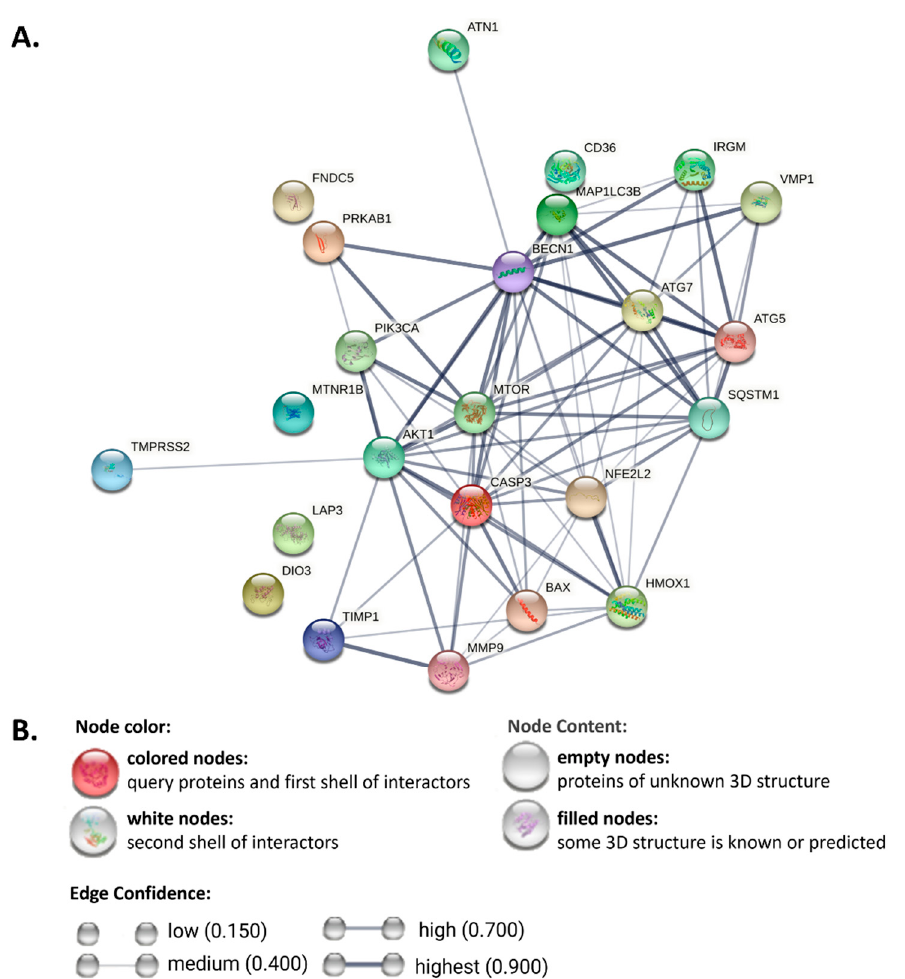
Figure 2. Functional enrichment analysis of protein–protein interaction networks. ( A ) Autophagy ‐ related markers, proteins, and newly discovered autophagy regulators were selected to predict their interaction network via STRING. ( B ) The indicating colors and content of the nodes and the confidence of edges. ATN1: Atrophin-1; CASP3: caspase-3; DIO3: thyroid hormones; FNDC5: Irisin; HMOX1: HO ‐ 1; MTNR1B: melatonin receptor type 1B; NFE2L2: Nfr2; PIK3CA: PI3K; PRKAB1: